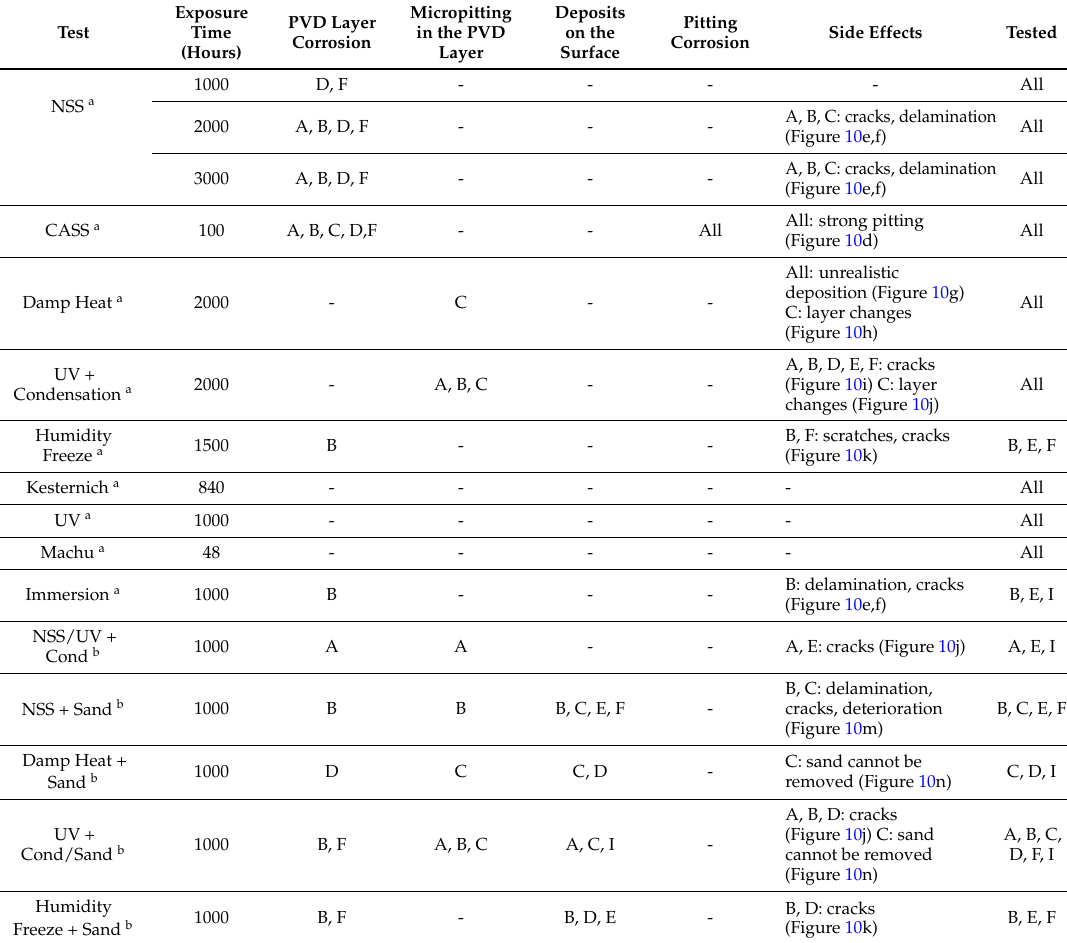
Table 4. Degradation mechanisms of the different materials under accelerated aging